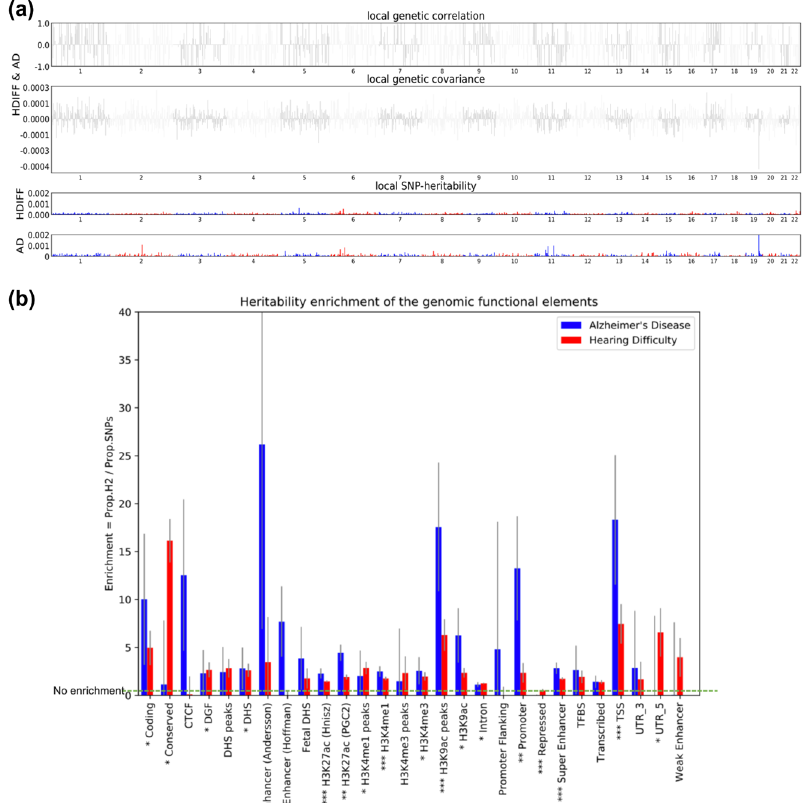
Fig. 1 Genomic region-based analysis plots. a Manhattan-style plots of local genetic correlation and covariance (top) and local SNP heritability (bottom) for HDiff and AD . Local genetic correlation corresponds to genomic regions that contribute signi fi cantly to the genome- wide genetic correlation. Local genetic covariance corresponds to the similarity between HDiff and AD driven by genetic variations localized at a speci fi c region in the genome. b Heritability enrichment (% of heritability/% of SNP) values in HDiff and AD SNPs located in each of 27 genomic functional elements. Error bars represent jackknife standard errors around the estimates of enrichment. Key: CTCF CCCTC-binding factor, DGF digital genomic footprint, DHS DNase I hypersensitive site, TFBS transcription factor binding site, TSS transcription start site, UTR untranslated region. Single, double, and triple asterisks indicate signi fi cance at P < 0.05 after Bonferroni-correction in HDiff , AD , and both HDiff and AD,